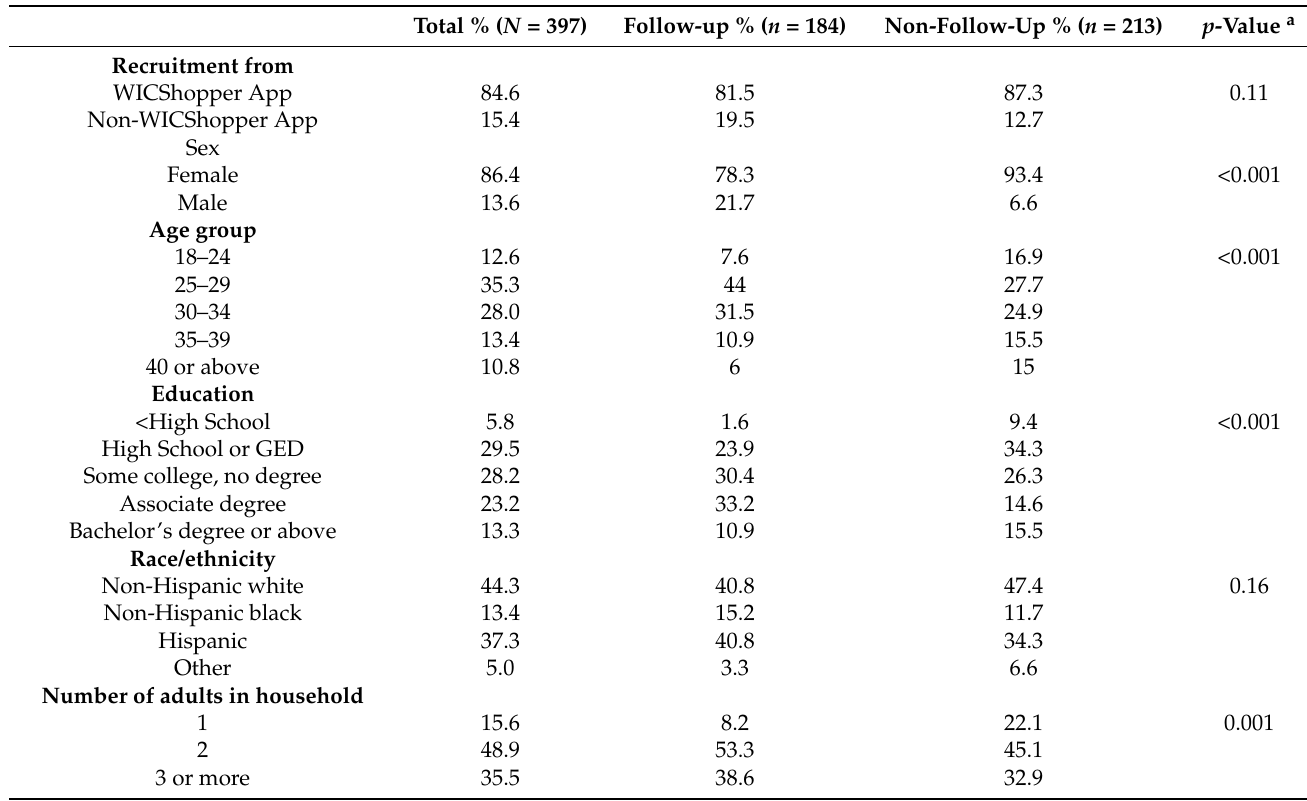
Table 1. Descriptive statistics of caregivers in baseline surveys and by follow-up status ( N = 397). Total % ( N = 397) Follow-up % ( n = 184) Non-Follow-Up % ( n = 213) p -Value